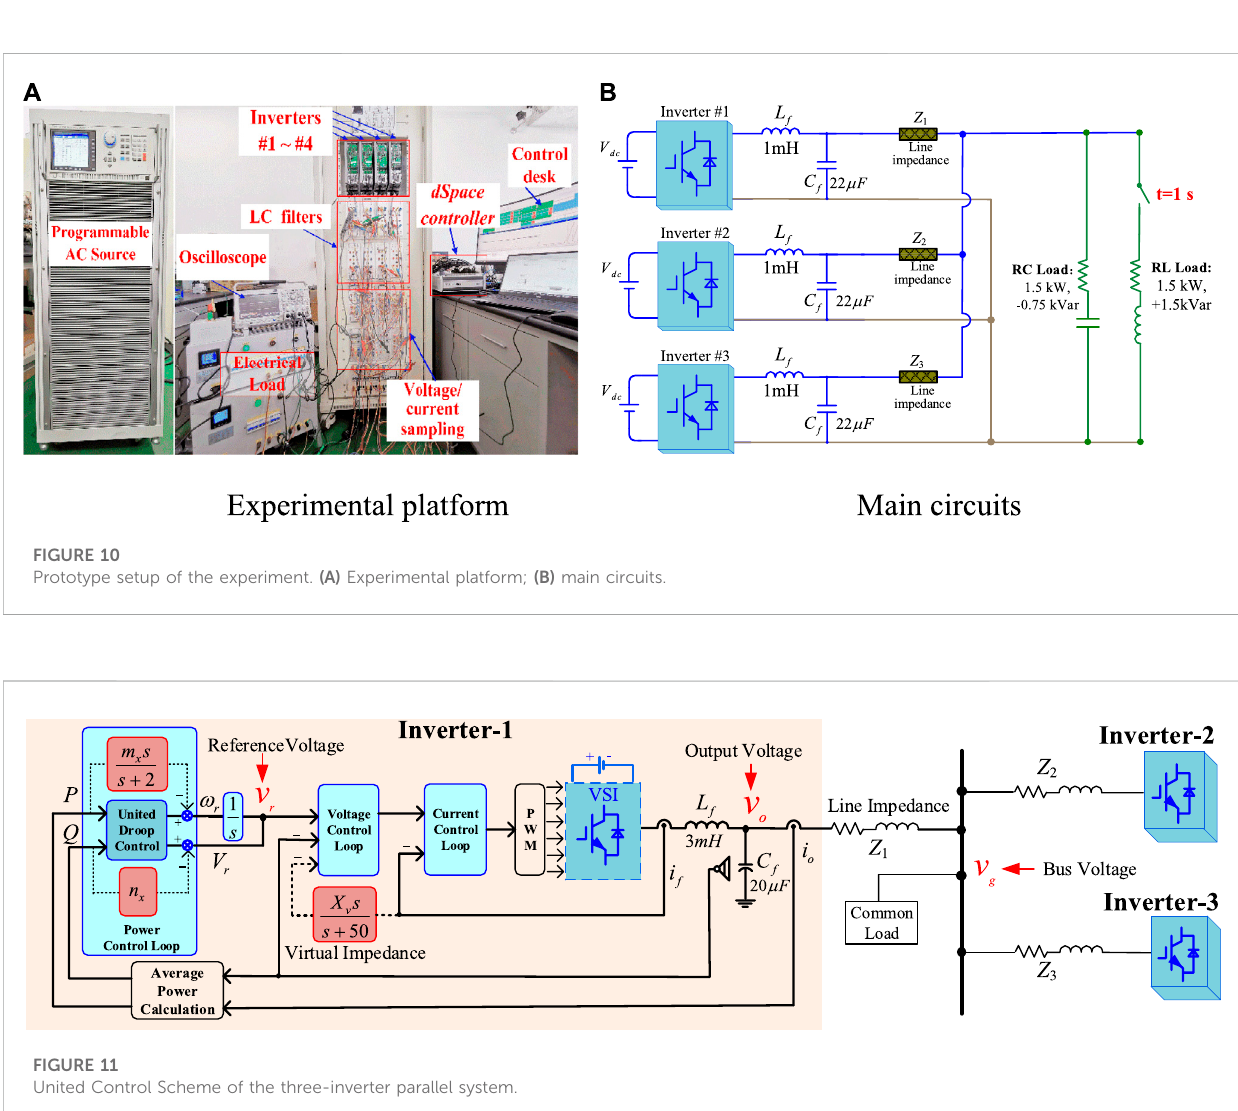
loop varies for different line impedance characteristics: in the purely-inductive case, there is basically no coupling; in the complex resistive-sensitive line and the purely resistive case, the coupling effect is stronger. In order to clearly express the decomposed active and reactive control in the three cases, the